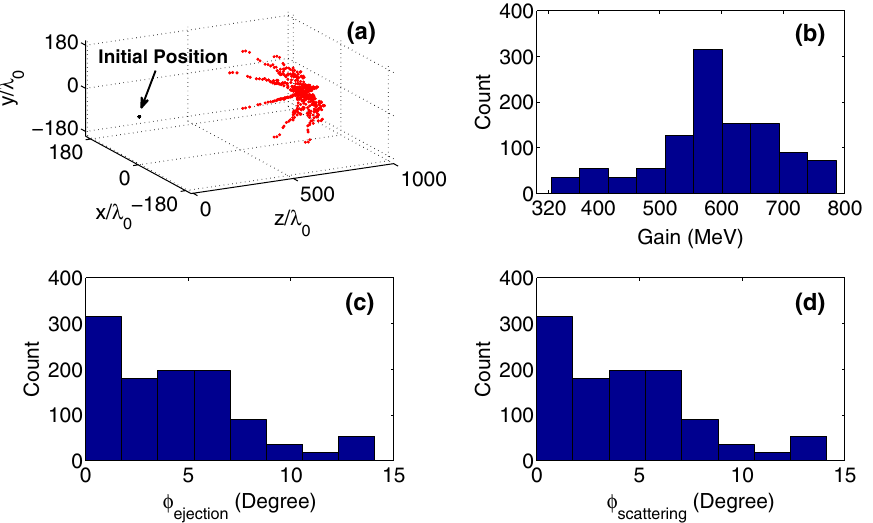
FIG. 3. Spatial distribution shown by the red dots in (a) as well as energy gain (b), ejection angle (cid:6) (cid:6) (d) of 1000 protons initially uniformly distributed within a cylinder of length L ¼ 0 : 6 (cid:9) m and radius R ¼ 0 : 3 (cid:9) m [shown scattering by the black dots in (a)] after 1000 T The center of the ensemble of protons is initially located at ð r; (cid:1); z Þ ¼ ð 0 ; 0 ; (cid:1) 3 : 7 (cid:7) The laser parameters are with a ¼ 0 , and the chirp parameter C ¼ 0 : 006 42 phase (cid:6) 0